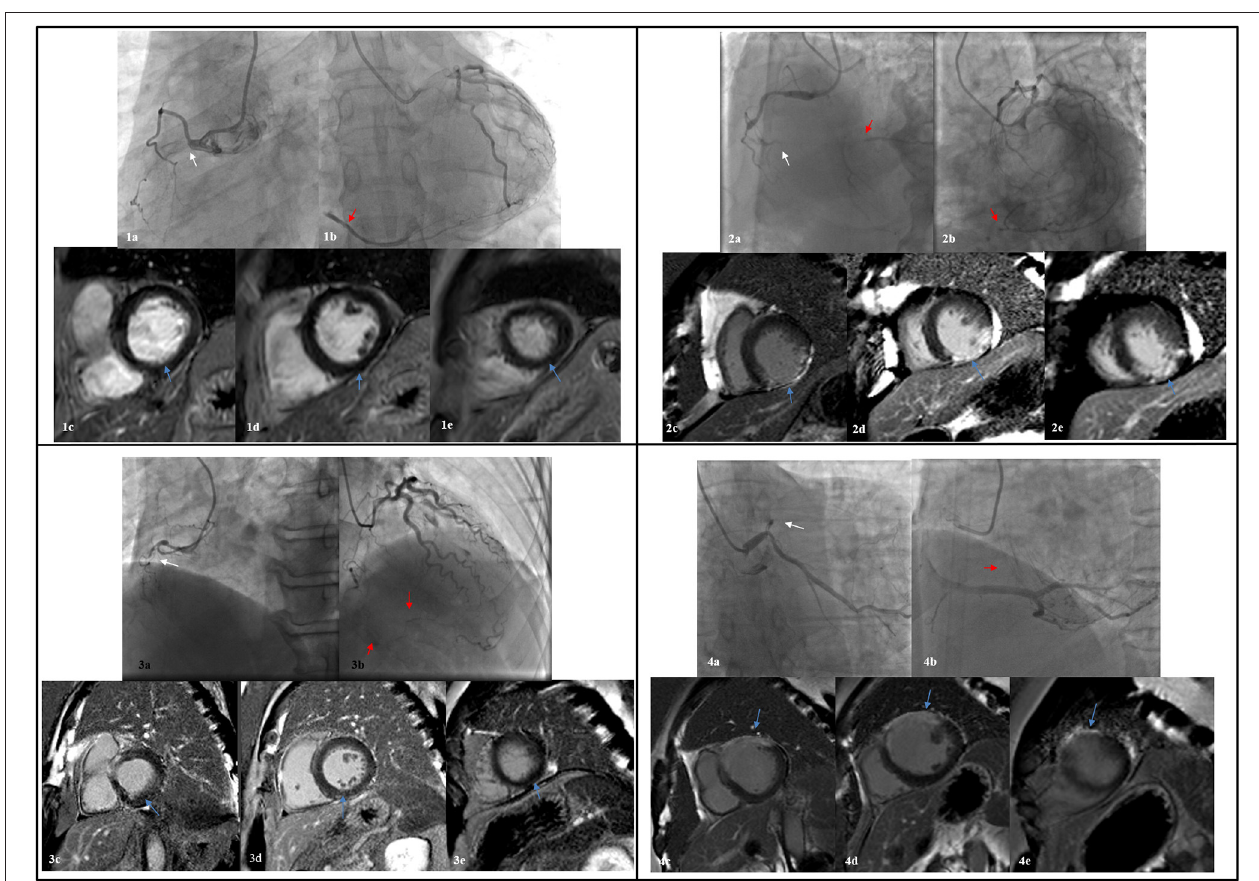
FIGURE 4 | Four typical case scenarios displaying patients with well- or poorly-developed collaterals and different extent of myocardial scar. 1: a, CTO in proximal RCA (white arrow); b, a well-developed epicardial collateral from LCX (red arrow); c-e, no myocardial scar of the inferior wall was observed from basal, intermediate, and to apex level. 2: a, CTO in distal RCA (white arrow); b, well-developed collaterals from LCX and septum branches (red arrow); c-e, transmural scar of the inferior wall was observed from basal, intermediate, and to apex level. 3: a, CTO in proximal RCA (white arrow); b, poorly-developed collaterals from septum branches (red arrow); c-e, no myocardial scar of the inferior wall was observed from basal, intermediate, and to apex level. 4: a, CTO in proximal LAD (white arrow); b, poorly-developed collaterals from septum branches (red arrow); c-e, transmural myocardial scar of the anterior wall was observed from basal, intermediate, and to apex level. CTO, chronic total occlusion; RCA, right coronary artery; LCX, left circumflex; LAD, left anterior